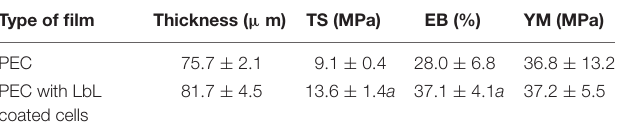
TABLE 3 | Effect of incorporation of LbL microencapsulated L. rhamnosus on PEC film thickness and mechanical properties*. Type of